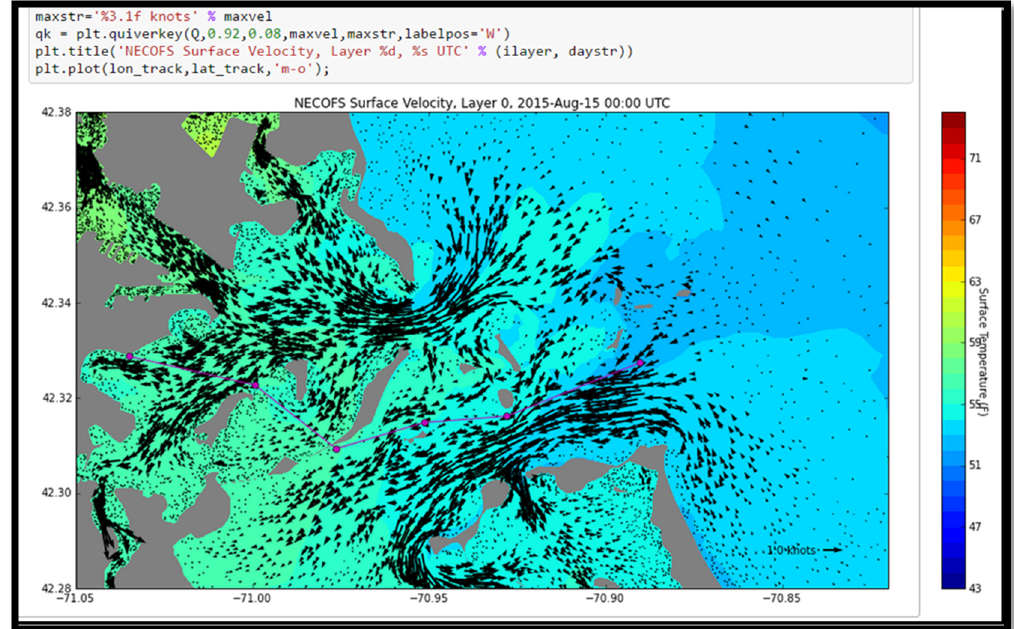
Figure 2. Screenshot from a web browser, displaying the original prediction of surface currents and forecast water temperatures in the Boston Harbor region from the IOOS NECOFS-MassBay model. This snapshot is at 00:00 UTC on the day of the Boston Light Swim, and is shown as embedded in a Jupyter Notebook given to the swim organizers. The magenta line indicates the eight-mile race route. The swimmers start offshore in colder water, and swim into the harbor following the incoming tide. The model is predicting 52–53 °F water temperatures at the race start, dangerously cold for a no ‐ wet suit swim.